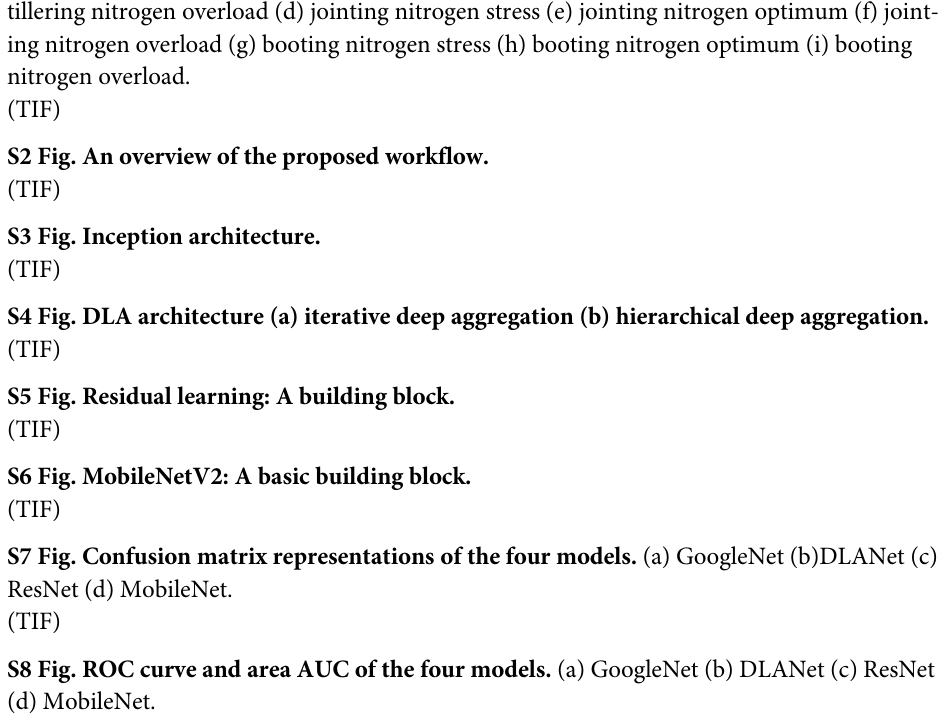
S2 Fig. An overview of the proposed workflow.